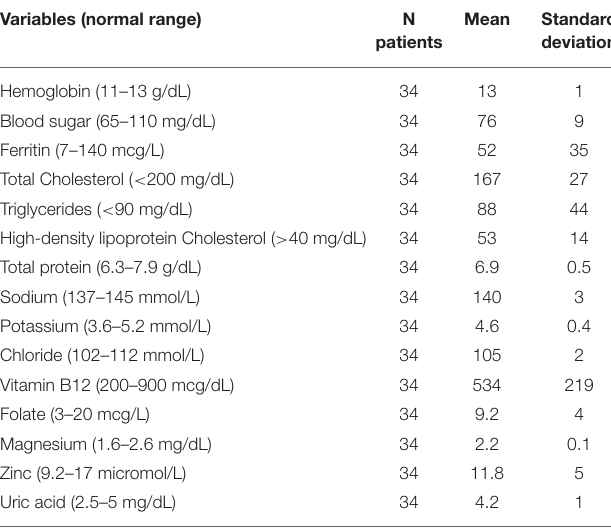
TABLE 1 | Summary of the most common laboratory values in DS children. Variables (normal range) N